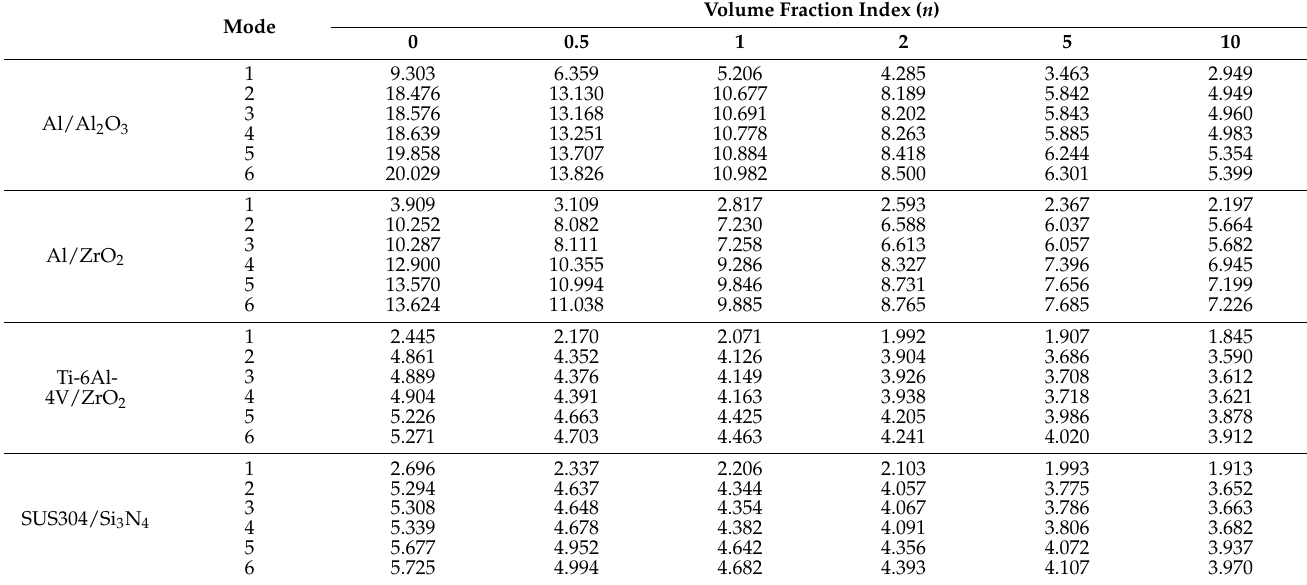
Table 8. Critical buckling load for the 1st six modes for various types of plates under biaxial